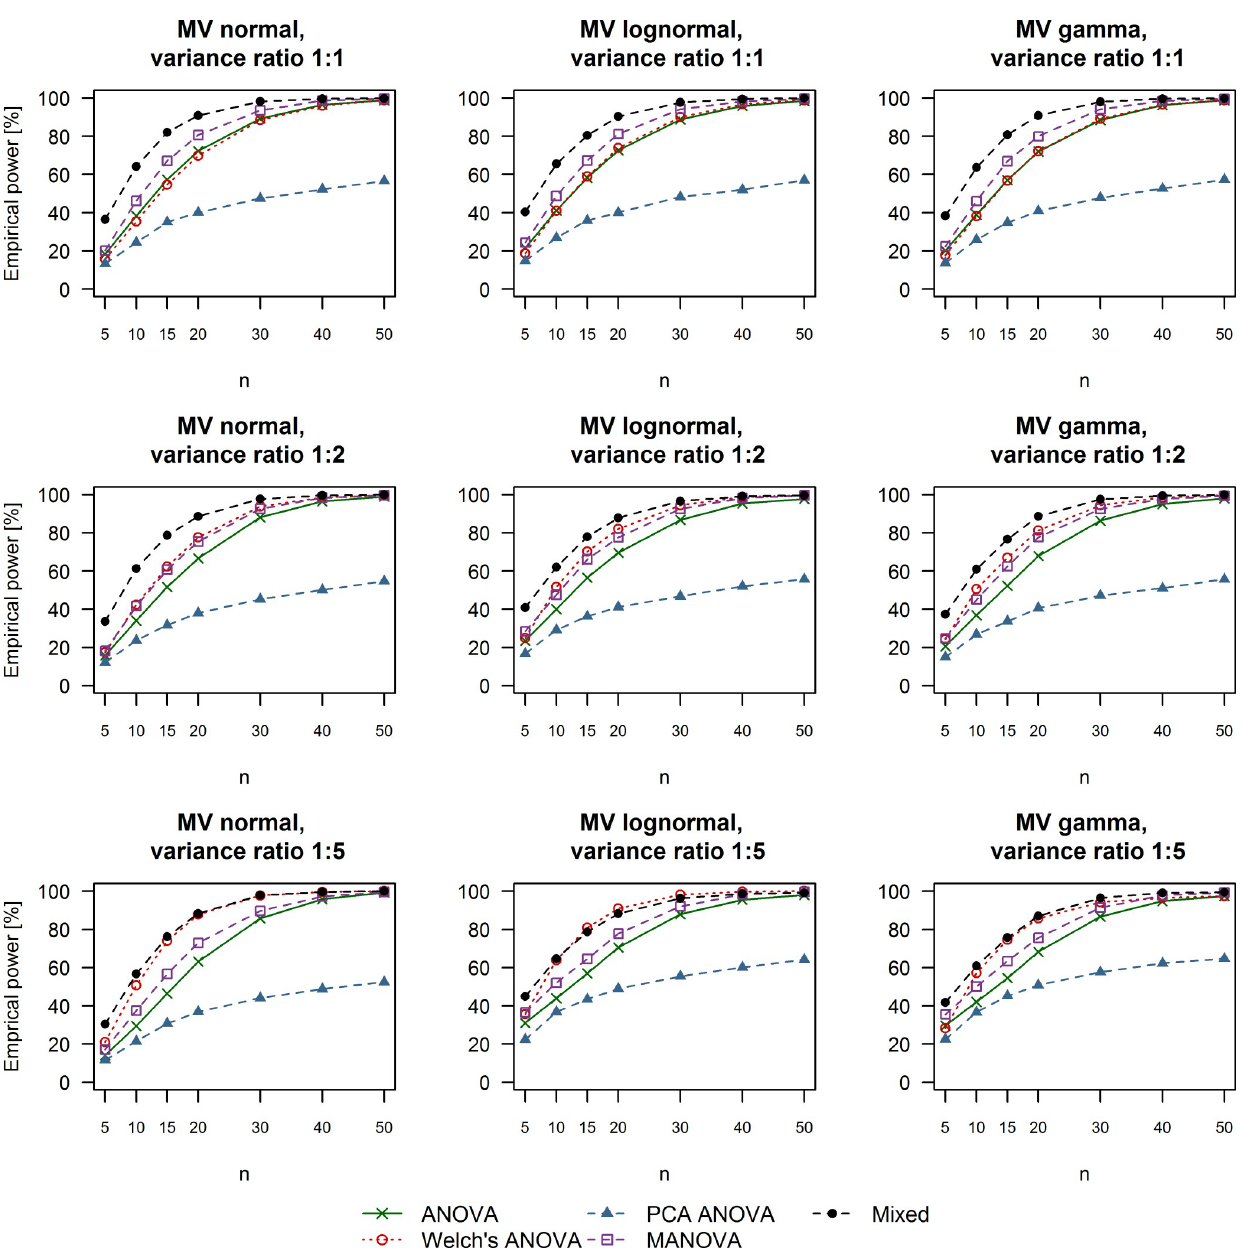
Fig 3. Empirical power of univariate and multivariate techniques in case of large treatment effects (Cohen’s d equal to 0.8). The multivariate distribution from which the data were drawn as well as the variance ratio between simulated control and treatment groups are summarized in the title of each respective plot. ANOVA: Analysis of variance; MANOVA: Multivariate analysis of variance; Mixed: Linear mixed effects model; MV: Multivariate; PCA: Principal component analysis. https://doi.org/10.1371/journal.pone.0230798.g003 data sets with huge treatment effects (Cohen’s d equal to 2.0) with 5 measurements per group and investigated how often the control group was separated from treatment groups in reduced multivariate space. PLS-DA managed to capture the true treatment pattern in 13.8% of the cases whereas PCA only separated the control from treatment groups in 7.7% of the simula- tions. RDA only marginally outperformed PCA and reported a true treatment effect pattern in 9.6% of the cases (the complete simulated set of plots is available in S3 Appendix).